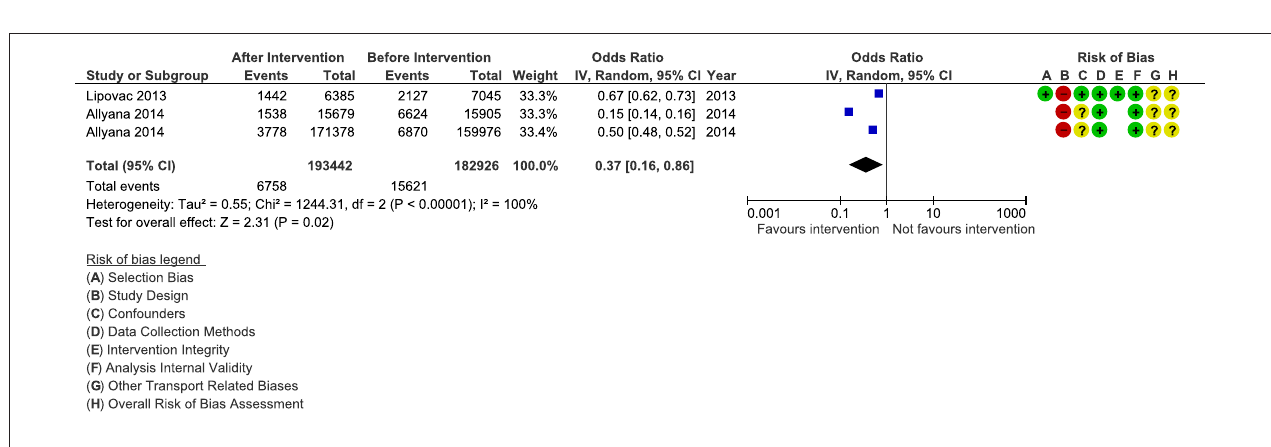
FIGURE 9 | Secondary outcome: changes in ‘red light and speed limit non-compliance’ after enforcement of traffic laws and regulations.